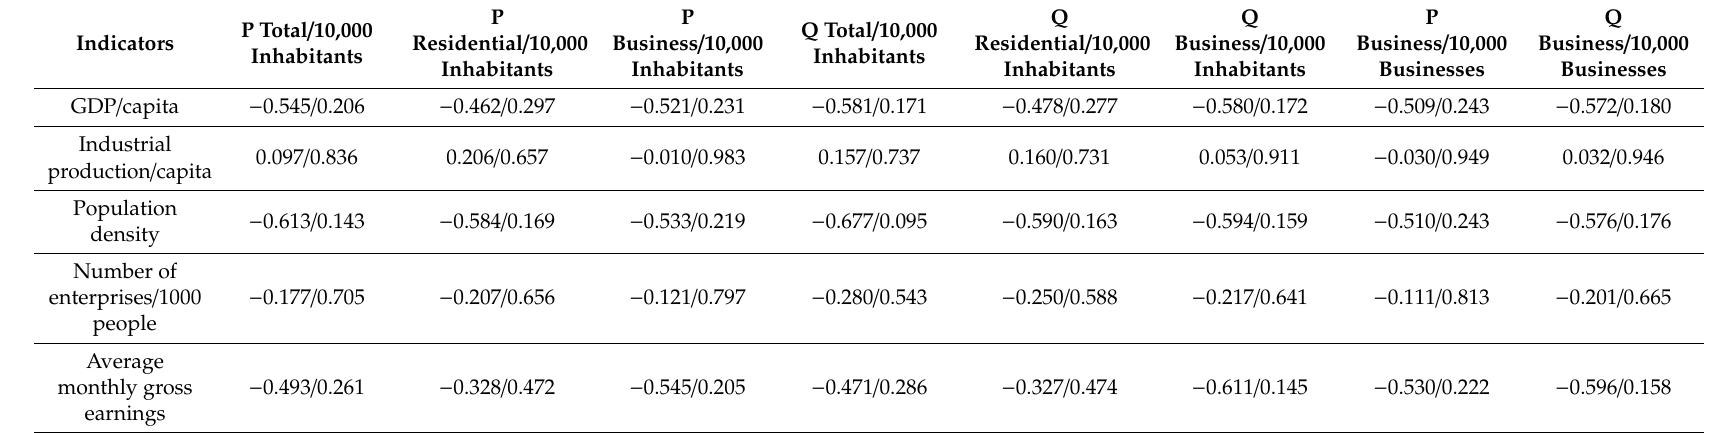
Table 8. The strengths of the relationships regarding the regions * (* Pearson correlation coe ffi cient / p -value): There exists a significant, verified relationship between two variables if p <